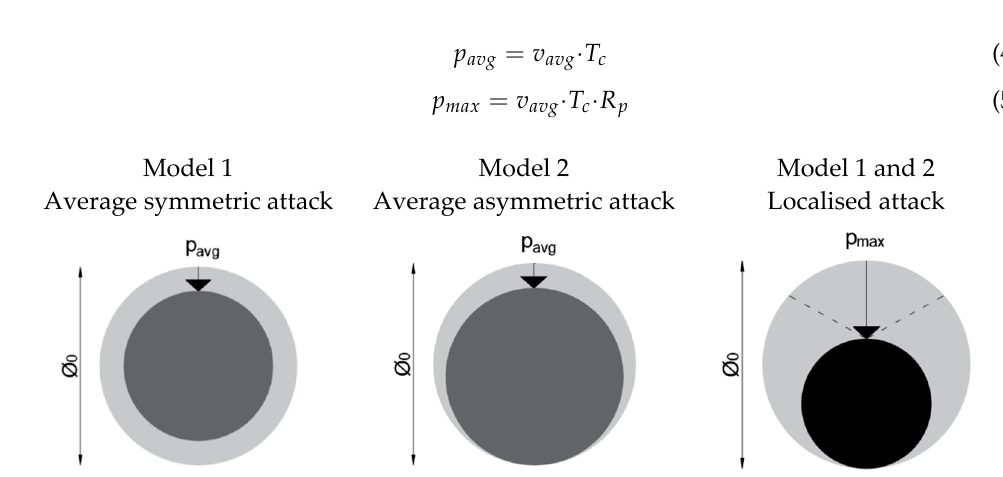
Figure 6. Equivalent average (dark grey) and minimum (black) residual bar cross-section for a given attack penetration.